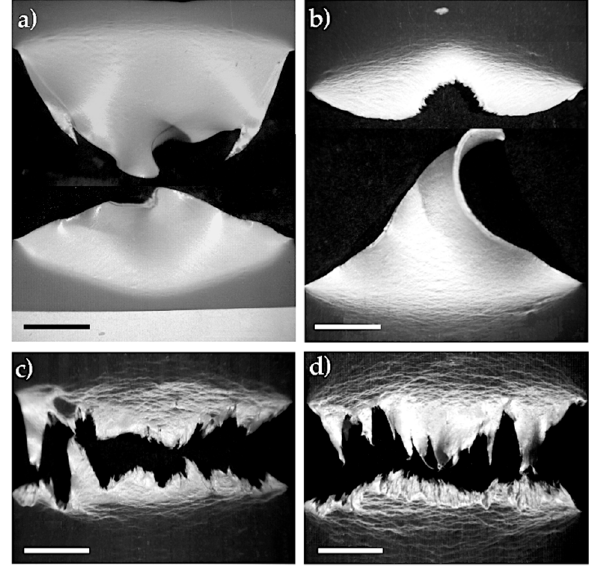
Figure 10. Appearance of the process zones (nominal ligament region: 13 mm) of studied materials after testing: ( a ) rPP, ( b ) 90/10, ( c ) 80/20, and ( d ) 70/30. Scale bars = 3 mm.